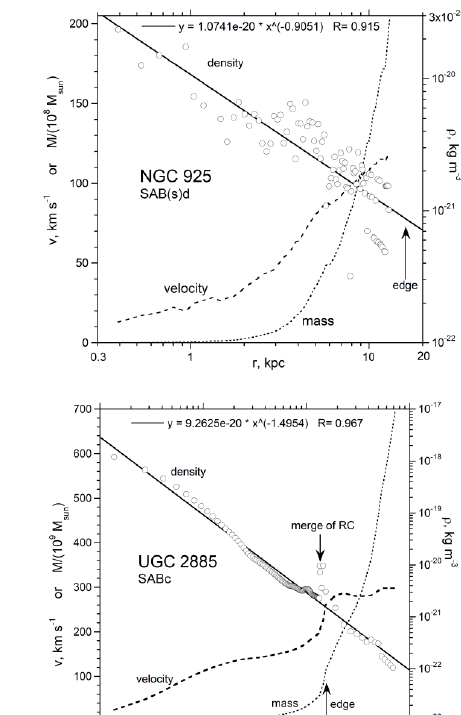
Figure A1. Andromeda. Inverse models showing the effect of varying c / a for an externally probed galaxy, with the most extensive RCs available. Compiled RCs of Sofue [59] are used to calculate: ( a ) M in and; ( b ) density vs. radius. Labels on curves list the aspect ratios considered.